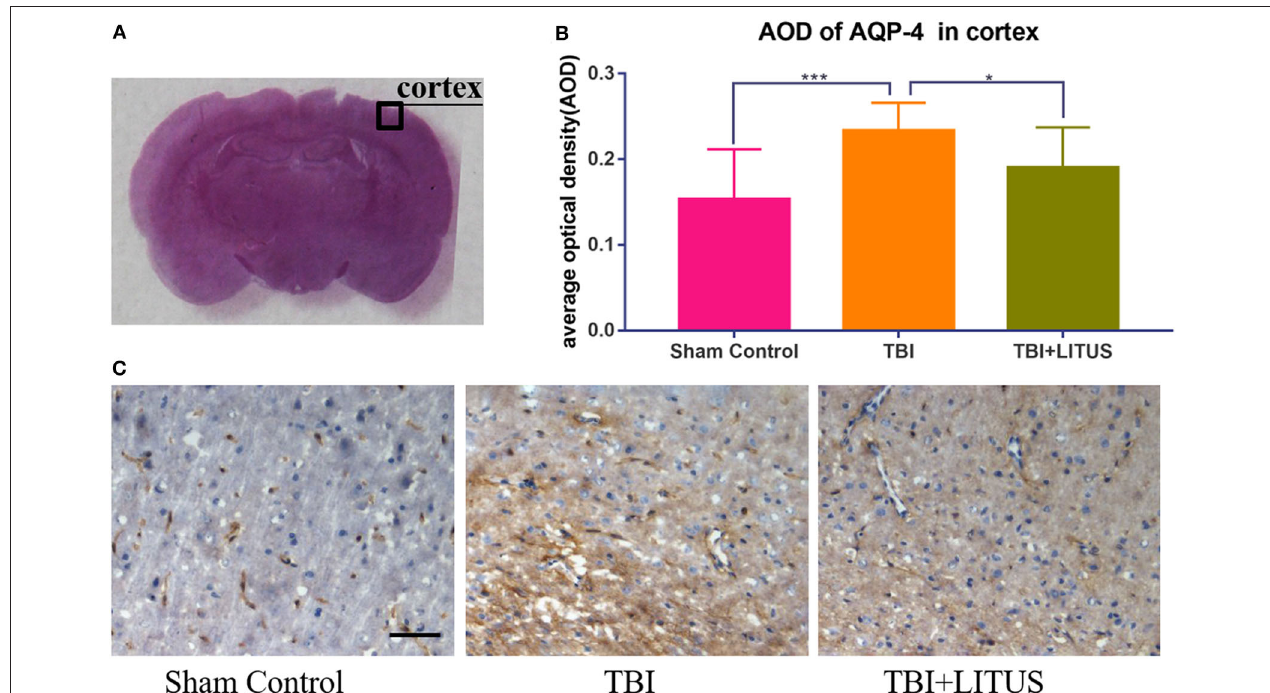
FIGURE 6 | Histopathology in the ipsilateral cortex at 42 days after TBI. (A) Representative images of AQP-4 stained neurons at injury cortex. (B) The AOD of rats in the TBI + LITUS group was 0.19 ± 0.05. The AOD for the TBI group was 0.23 ± 0.03, indicating LITUS can significantly promote the expression of BDNF AQP-4 staining of the cortex of rat brains of sham control, TBI and TBI + LITUS groups at 42 days after injury. (C) Compared to sham control rats, the number of AQP-4 stained cells in the damaged cortex of the TBI group was significantly increased. The number of cell damage in the TBI + LITUS group was significantly less than that in the TBI group, which indicated that LITUS had a good neuroprotective effect. Bar, 50 µ m. Data are mean ± SD, n = 10. Tukey’s post-hoc test, * P < 0.05, *** P <